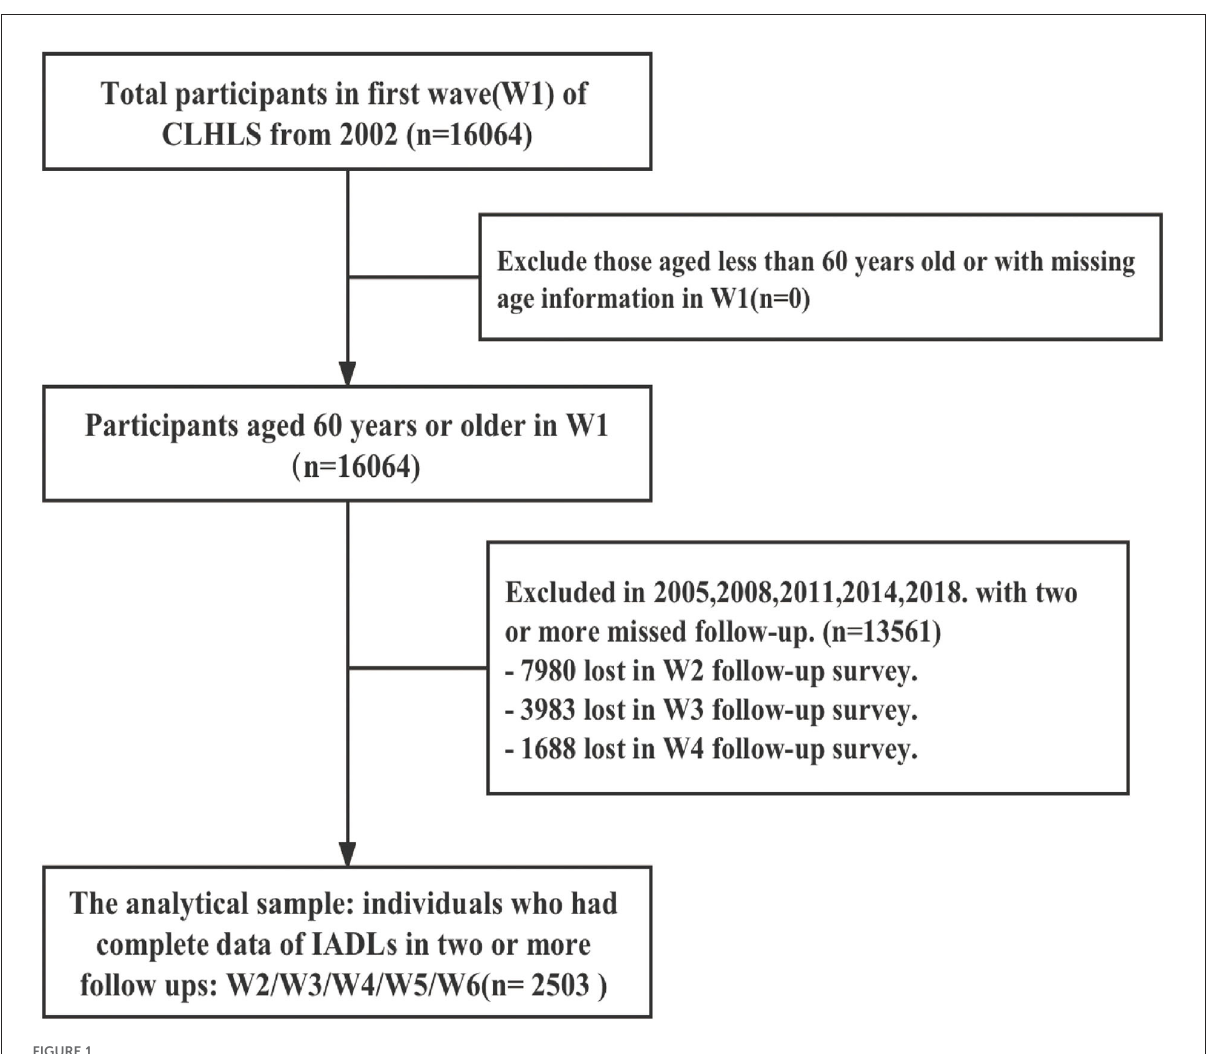
FIGURE1 Flowchart of the study